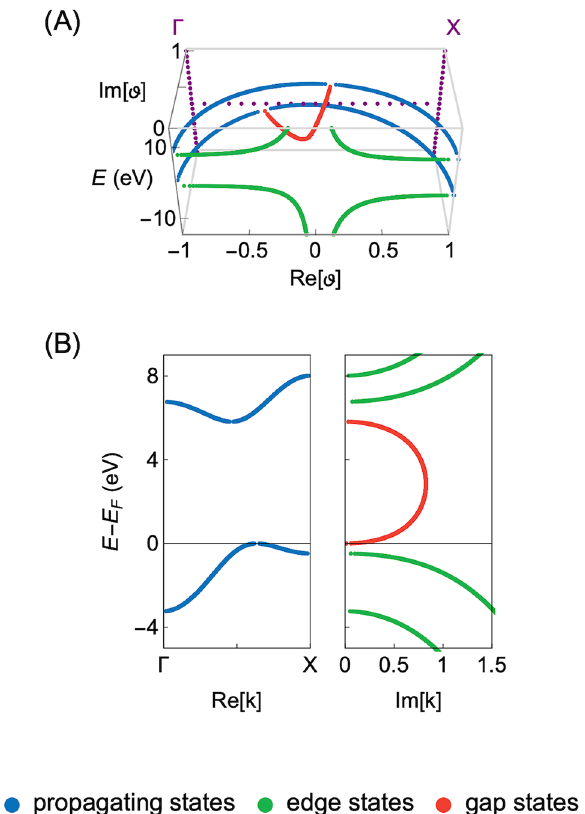
Figure 1. ( A ) The complex band structure of the unperturbed CsCl insulator ( (cid:31) 1, 1 Im 0, 1 ϑ ϑ of ϑ for Re . ( B ) The complex band structure of the unperturbed CsCl insulator [ ] ∈ �− � ∩ [ ] ∈ � � projected on the Re[ k ] (left panel) and Im[ k ] axes (right panel). The propagating, edge and gap states are distinguished by the blue, green and red color, respectively. Moreover, the zero energy level is set at the top of the valence